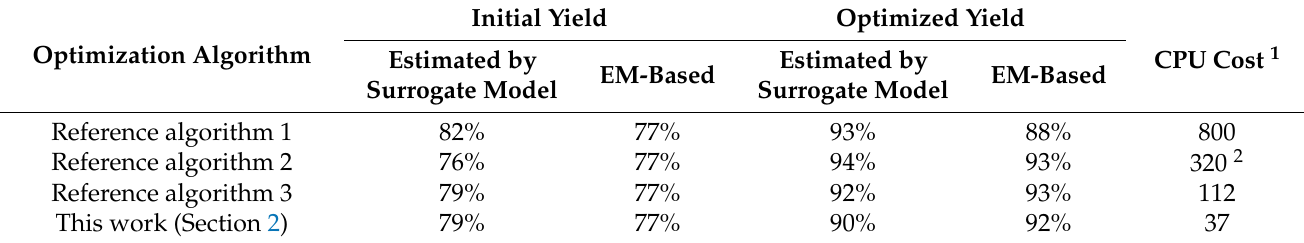
Table 3. Design centering results for Circuit II (Figure 3b).